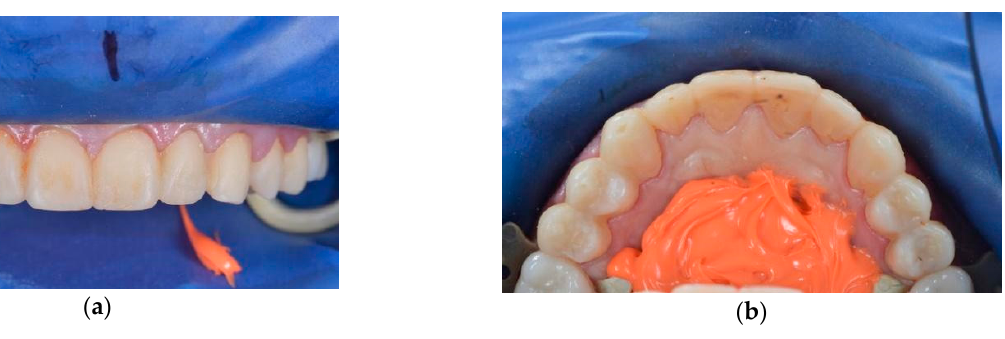
Figure 9. Intra-oral smile view before ( a ) and after ( b ) teeth alignment.